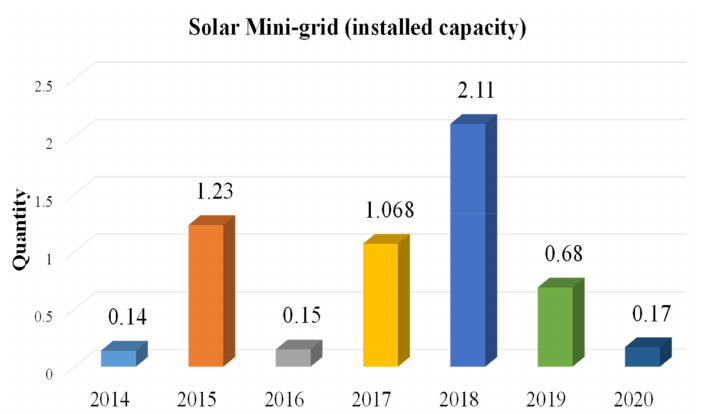
Figure 16. Historical yearly net installed capacity of solar mini-grids and nano-grids in Bangladesh (authors’ creation based on SREDA data